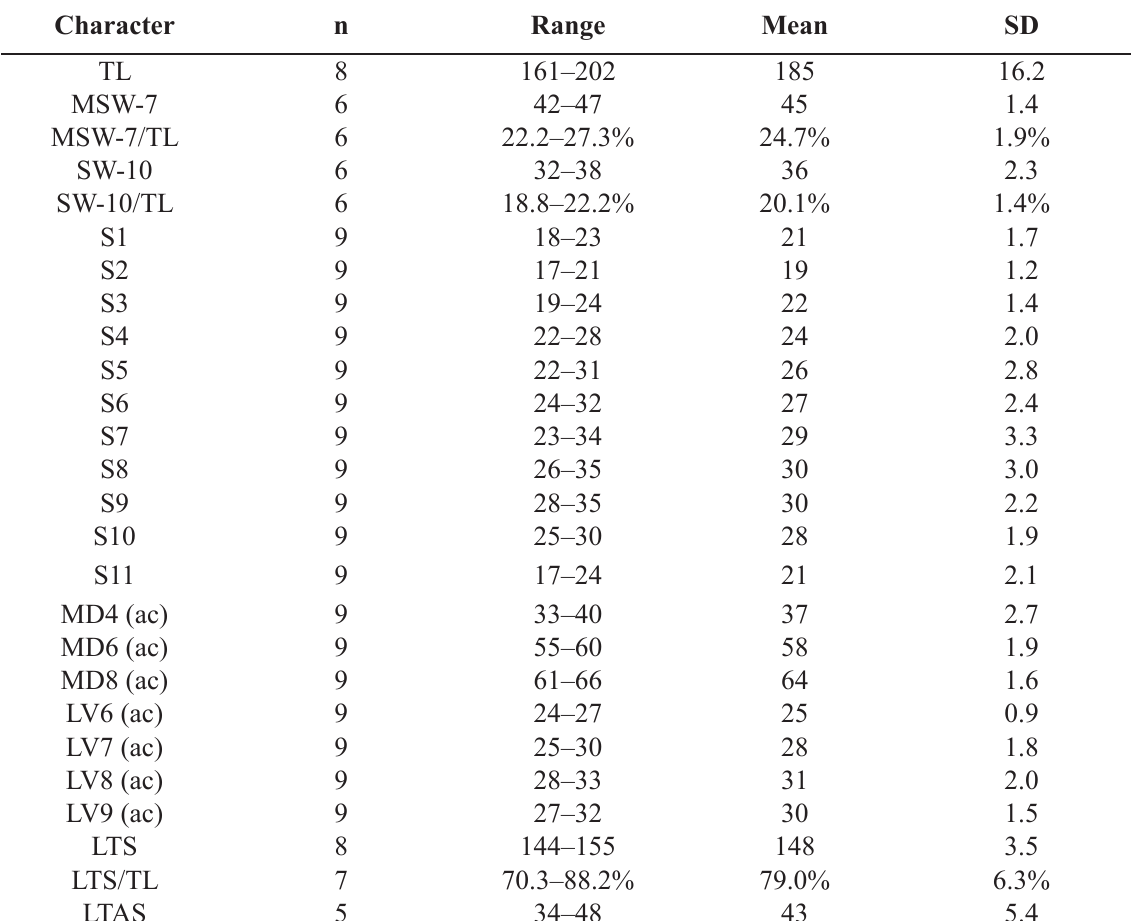
Table 12. Measurements from light microscopy of Echinoderes frodoi sp. nov . (in µm) from the Hikurangi Margin, including number of measured specimens (n) and standard deviation